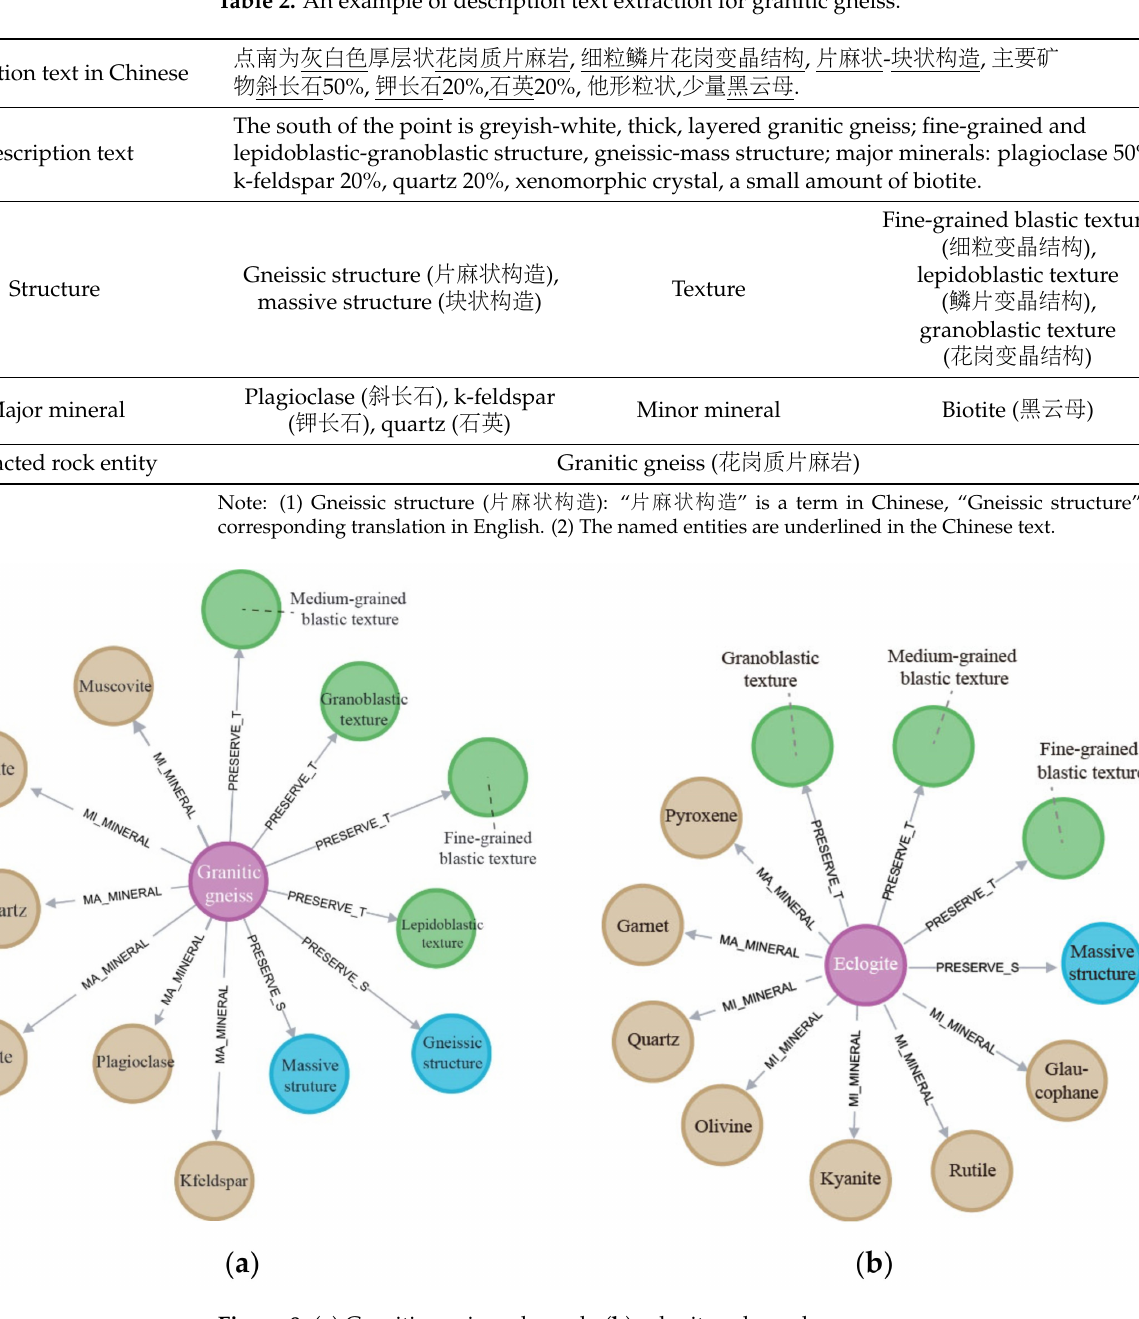
Figure 8. ( a ) Granitic gneiss subgraph; ( b ) eclogite